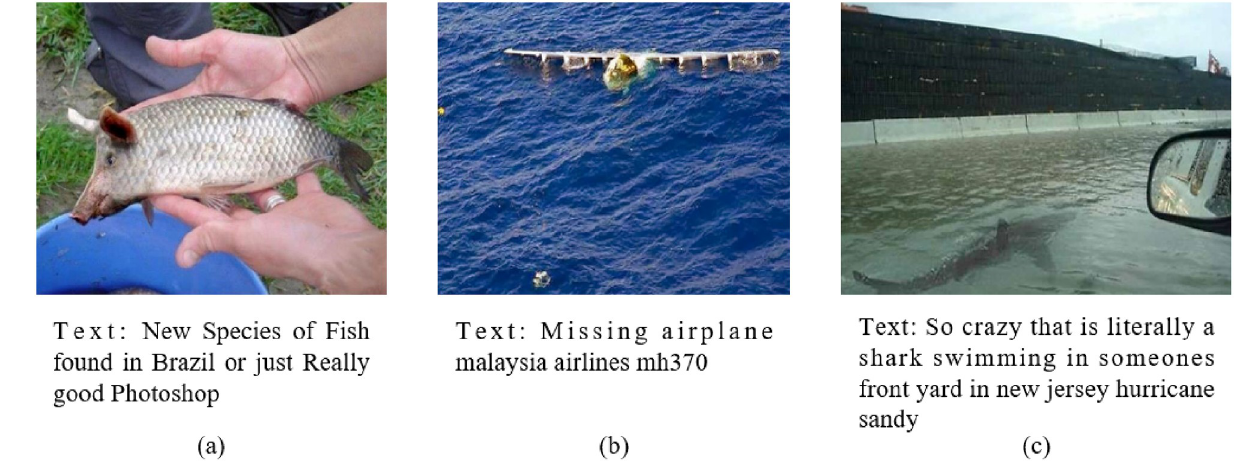
Fig 1. Example of fake news in the Twitter